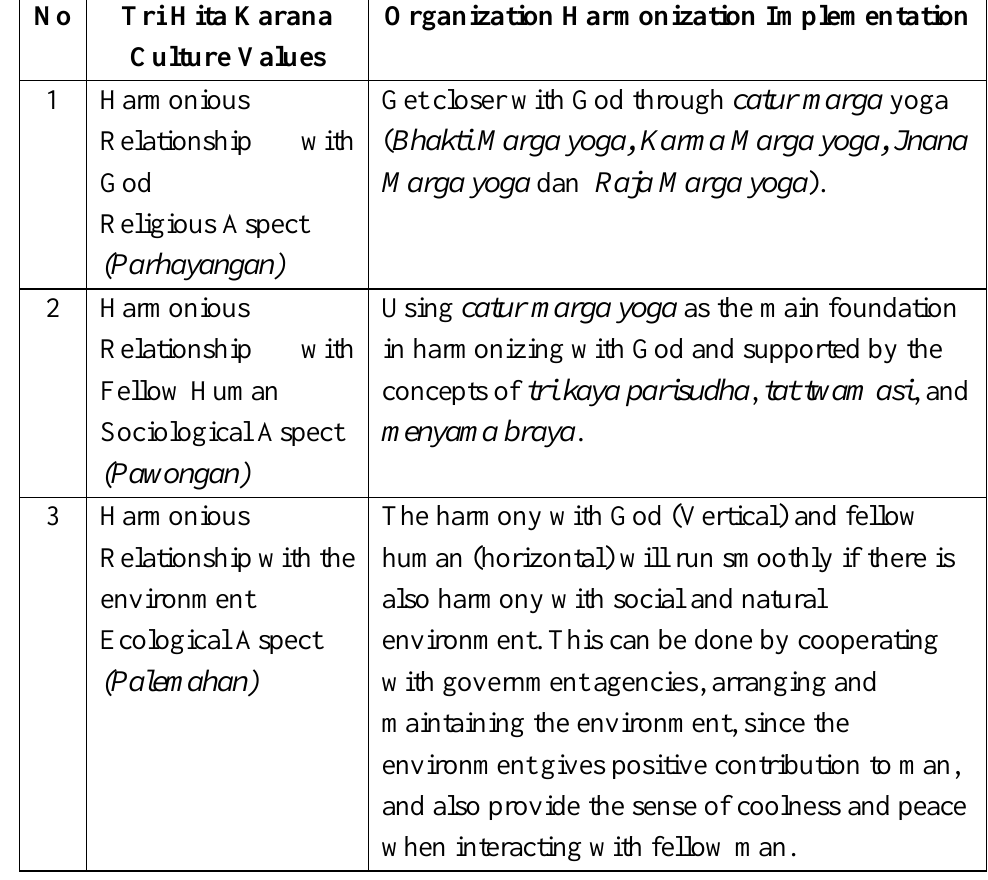
Table 1.1. Tri Hita Karana Culture Values in Organization Harmonization No Tri Hita Karana Organization Harmonization Culture Values